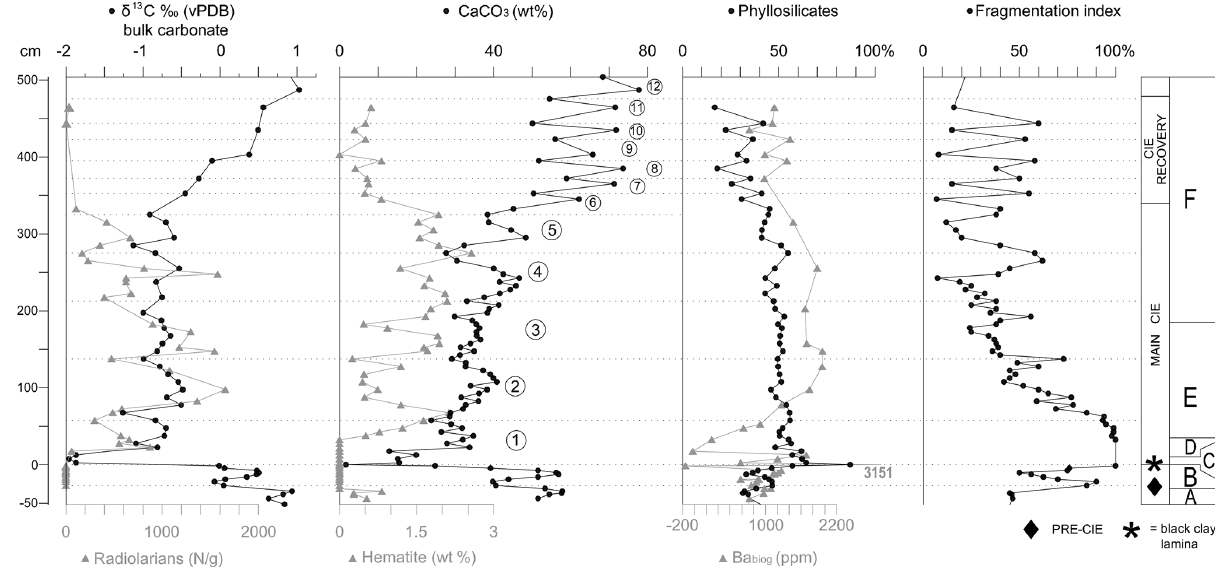
Figure 3. Summary of the main mineralogical, geochemical and cyclostratigraphic features recognized across the Paleocene–Eocene bound- ary and in the clay marl unit (CMU) of the Forada section and radiolarian abundance plotted against isotopic intervals and recognized benthic foraminiferal assemblages (A to F). Ng − 1 for the radiolarians refers to the number of radiolarians (>125µm fraction) per gram of dry sediment. F index from Luciani et al. (2007). VPDB – Vienna Pee Dee belemnite standard. Modified from Giusberti et al.